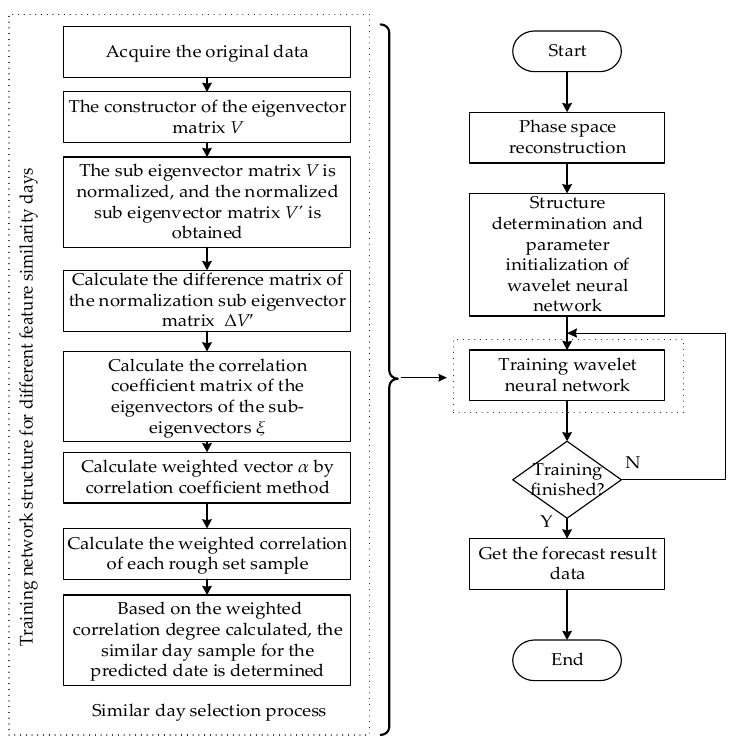
Figure 2. Prediction flow chart of WNN based on similar day selection.